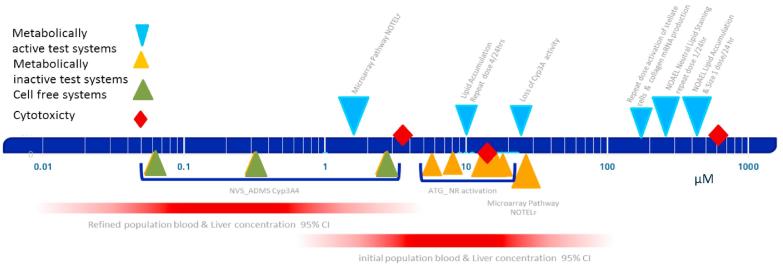
Illustration of predicted liver and blood concentrations of chemical X alongside in vitro assay results overlap. Differences in dose response are seen between the different test systems, e.g. Cyp3A4 an approx. 100 fold difference in concentration between cell free and the metabolically active HepaRG cells. This needs to be taken into account when translating the data for in vivo relevance. These data could be considered as possible points of departure for chemical x. Reprinted from OECD [69].)